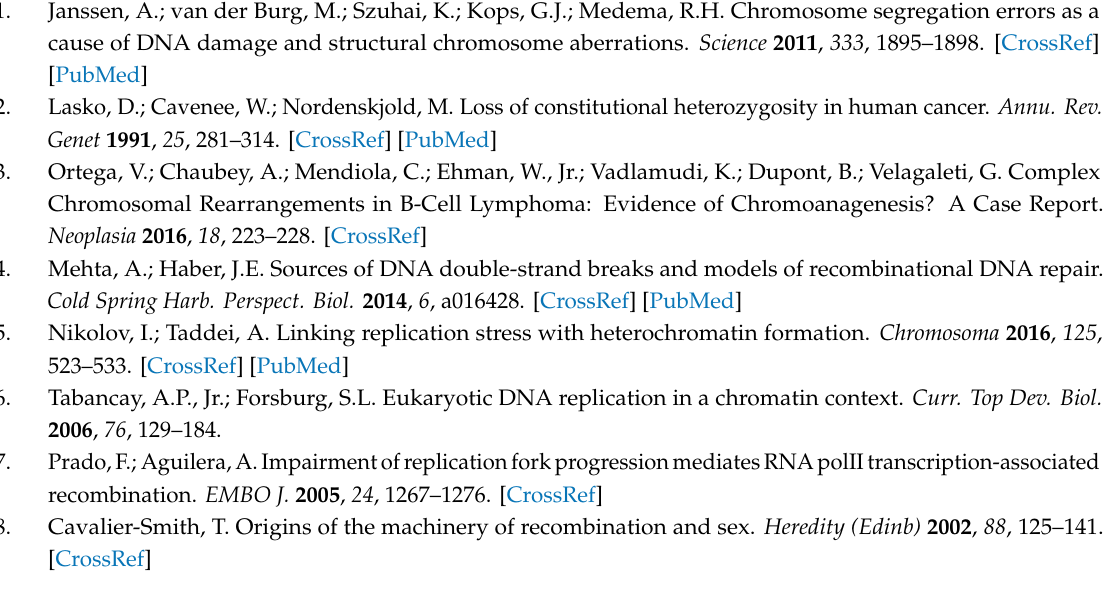
Figure S1: Analysis of Ura + His + recombinants, Figure S2: Sensitivity of strains to MMS, Table S1: Strains used in this study, Table S2: Descriptive statistics for spontaneous breaks when cells were released in Edinburgh Minimal Media and platted on EMM-Uracil with Phloxin B, Table S3: Descriptive statistics for spontaneous breaks when cells were released in Edinburgh Minimal Media and platted on EMM-Uracil without Phloxin B, Table S4: Descriptive statistics for induced breaks when cells were released in Edinburgh Minimal